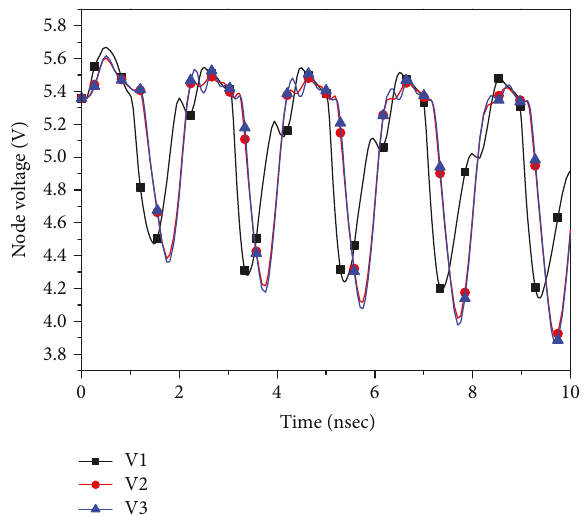
Figure 8: Voltages of nodes 1, 2, and 3 with 500MHz sinusoidal signal source added in port 1.